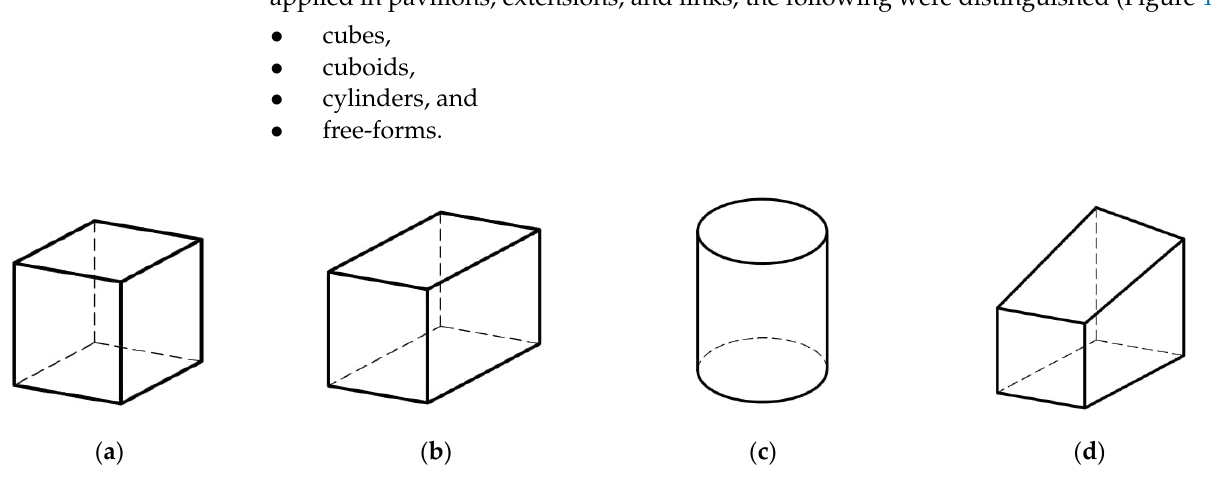
Figure 9. The footbridge at the John Lewis Department Store in Leicester: ( a ) view of the footbridge from the Vaughan Way, (© Satoru Mishima); ( b ) section through building John Lewis Department Store and Parking, (© AZMPL).